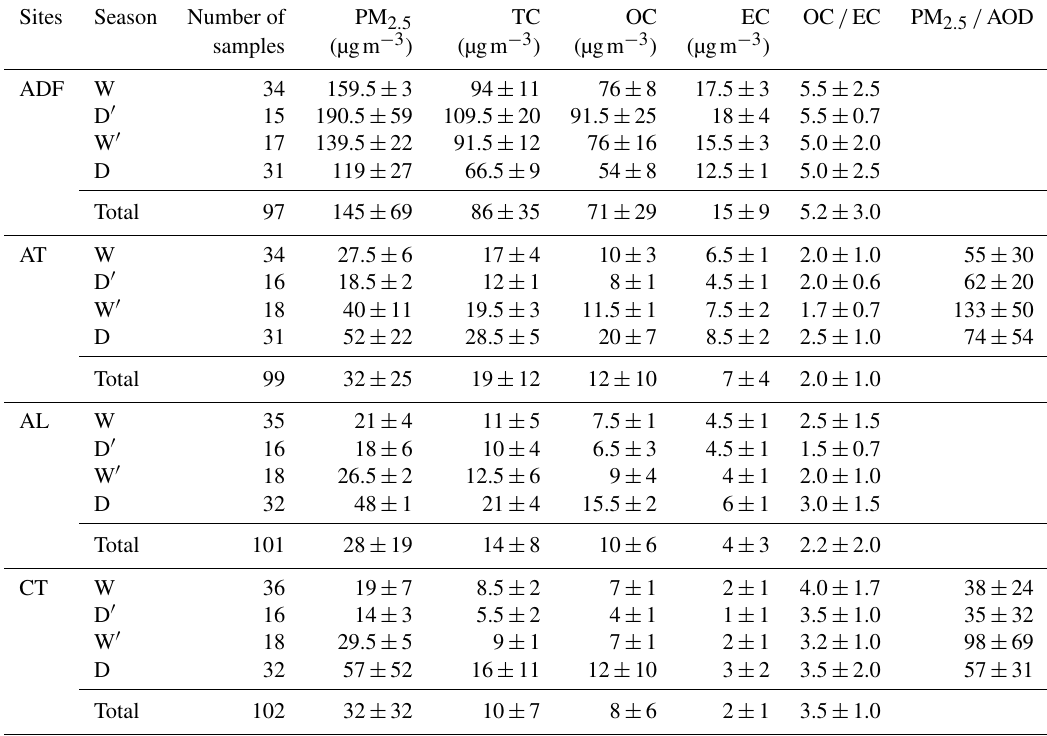
Table 2. Seasonal average of PM 2 . 5 concentrations, carbonaceous matter and ratio between PM 2 . 5 and AOD for Abidjan/domestic fires (ADF), Abidjan/traffic (AT) Abidjan/waste burning (AL) and Cotonou/traffic (CT) sites. Sites Season Number of PM 2 .